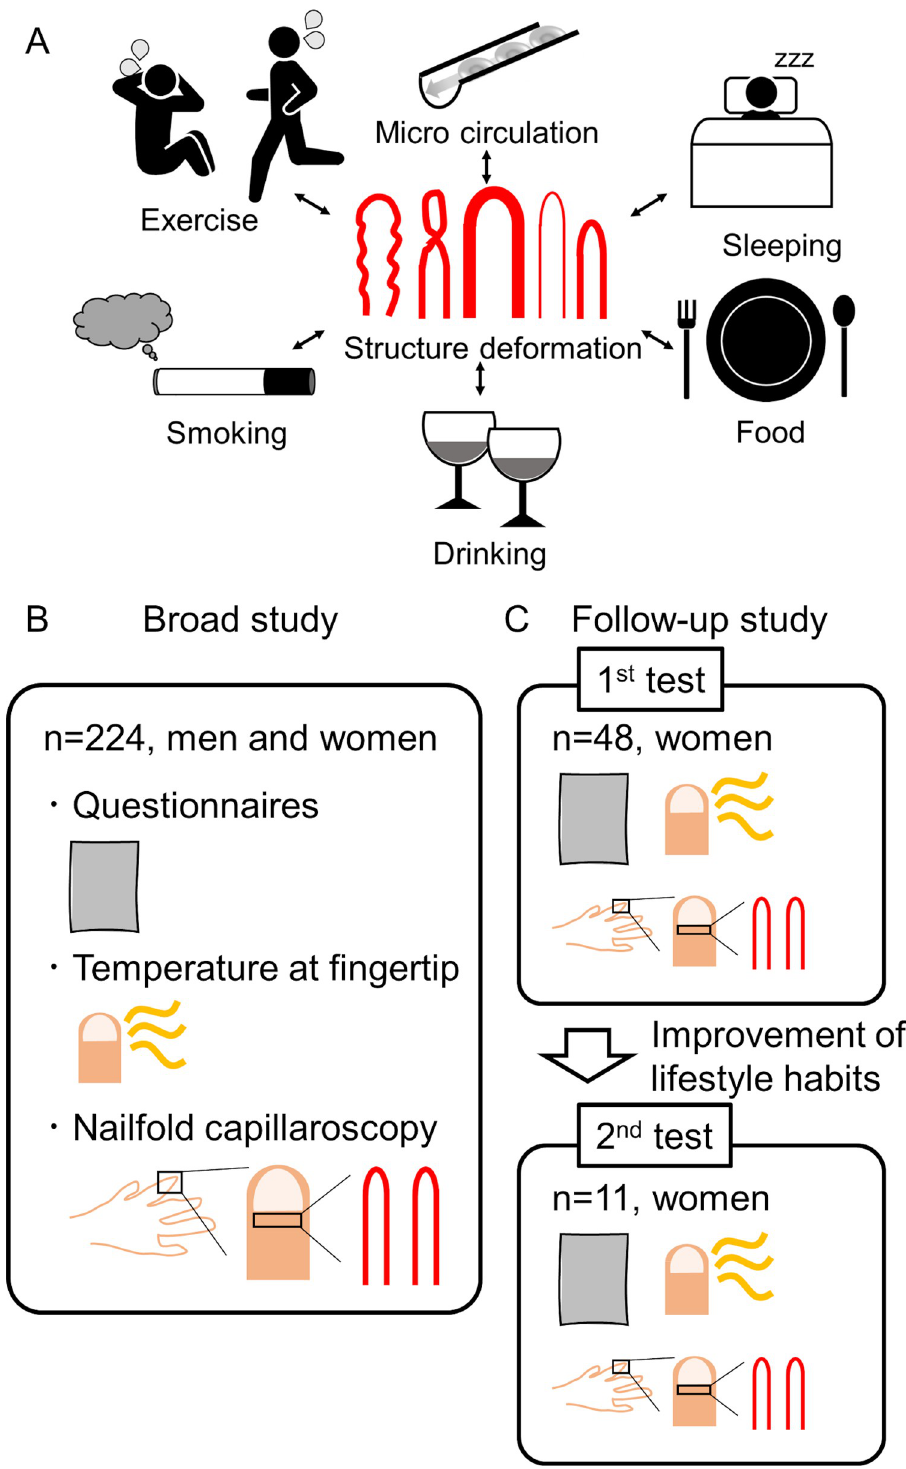
Fig 1. Study design. A: Schematic representation of the study to evaluate the correlation between pattern of nailfold capillaries and lifestyle habits. Clinical experimental design for the broad study (B) and follow-up study (C). In the broad study, both men and women participated, and data were collected as questionnaires for lifestyle habits, fingertip temperatures, and images using nailfold capillaroscopy. In the follow-up study, women participants addressed the improvement in lifestyle habits after the first test, and data were reanalyzed after 1–2